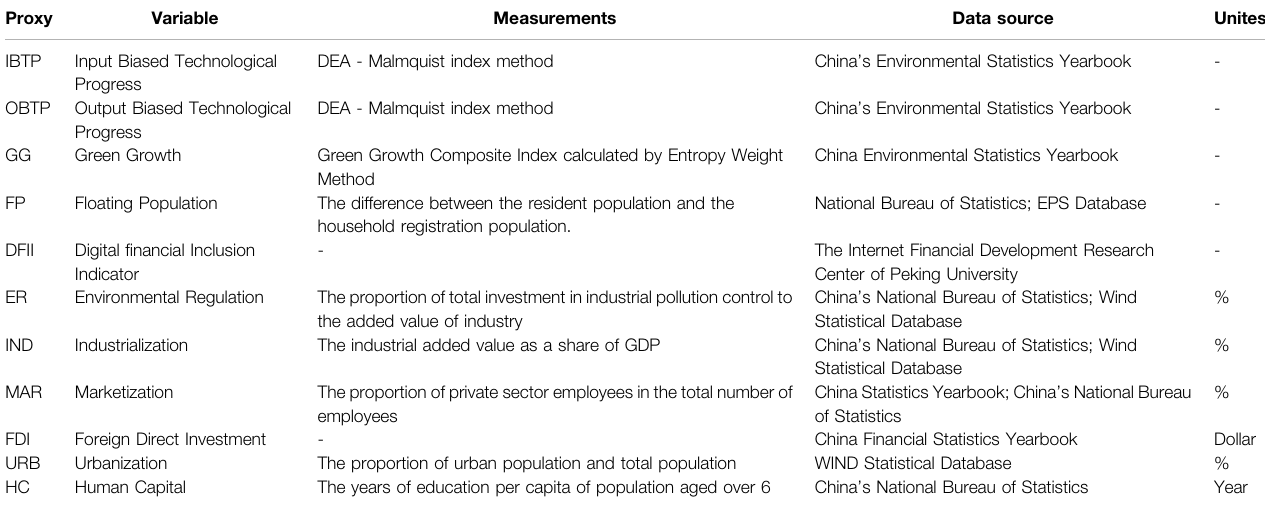
TABLE 4 | Variable speci fi cation.